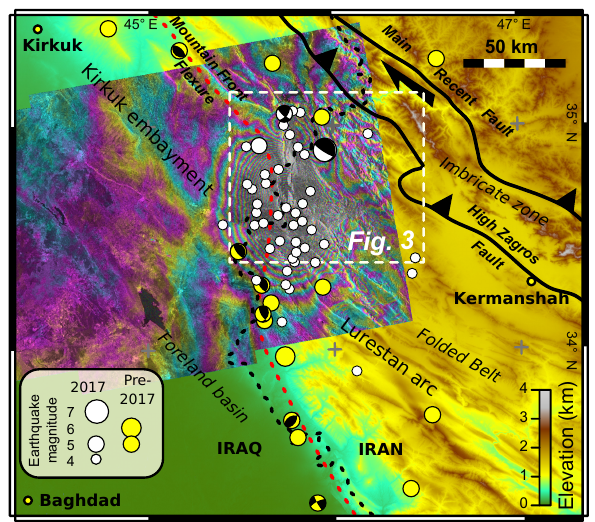
Figure 2. Elevation map (source: ESDIS) showing the main struc- tural features of the Lurestan region and earthquake distribu- tion (source: USGS, https://earthquake.usgs.gov/). M w > 4 earth- quakes of the November 2017 sequence are reported in white; pre-2017 M w > 5 earthquakes are reported in yellow. The Sen- tinel 1 co-seismic interferogram (11 November, 15:00UTC to 17 November 2017, 14:59UTC; http://sarviews-hazards.alaska.edu/ Event/34/; last access: 18 June 2018) is also shown as an